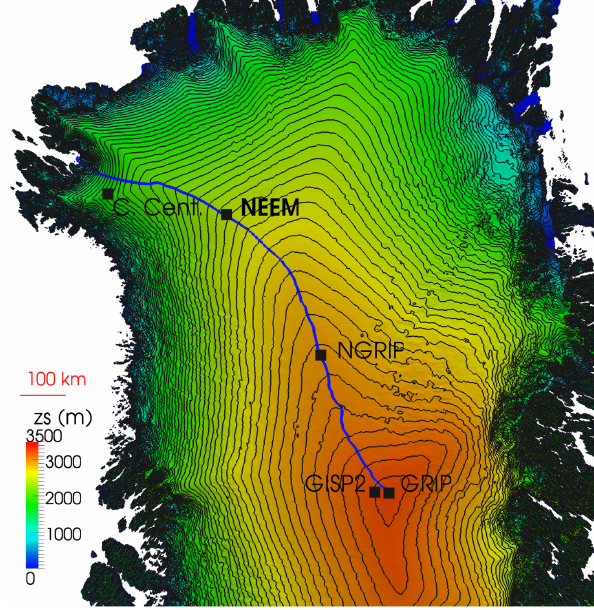
Figure 1. Greenland Ice Sheet surface elevation (Bamber et al., 2013) and location of the GRIP, GISP2, NGRIP, NEEM and Camp Century drilling sites. Contours are every 50m. A flow line follow- ing the greatest slope along the NNW ridge is shown in